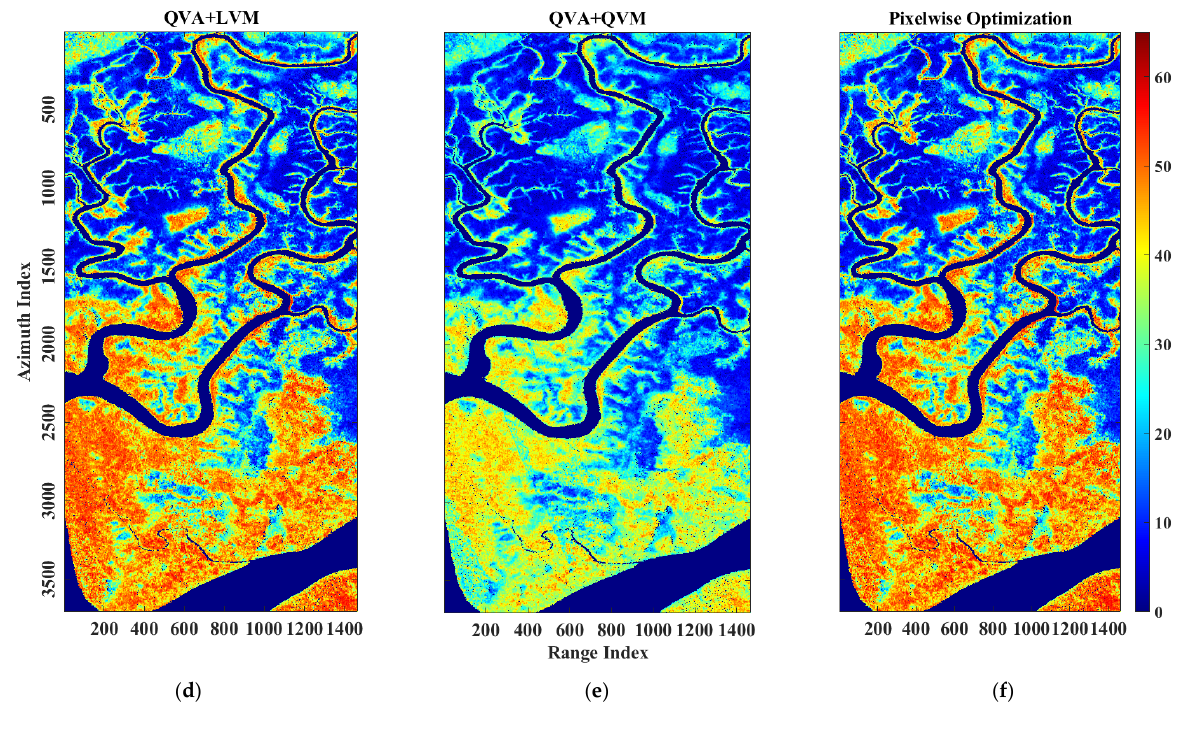
Figure 11. Forest height inversion results (in meters) over the PNP site based on different models. ( a ) LVIS RH100 height; ( b ) LVA + LVM; ( c ) LVA + QVM; ( d ) QVA + LVM; ( e ) QVA + QVM; ( f ) Pixel-wise optimization.